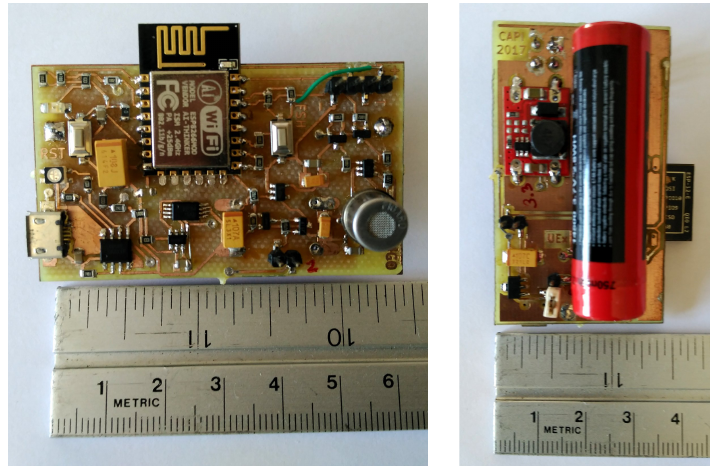
Figure 11. Image showing both sides of the final